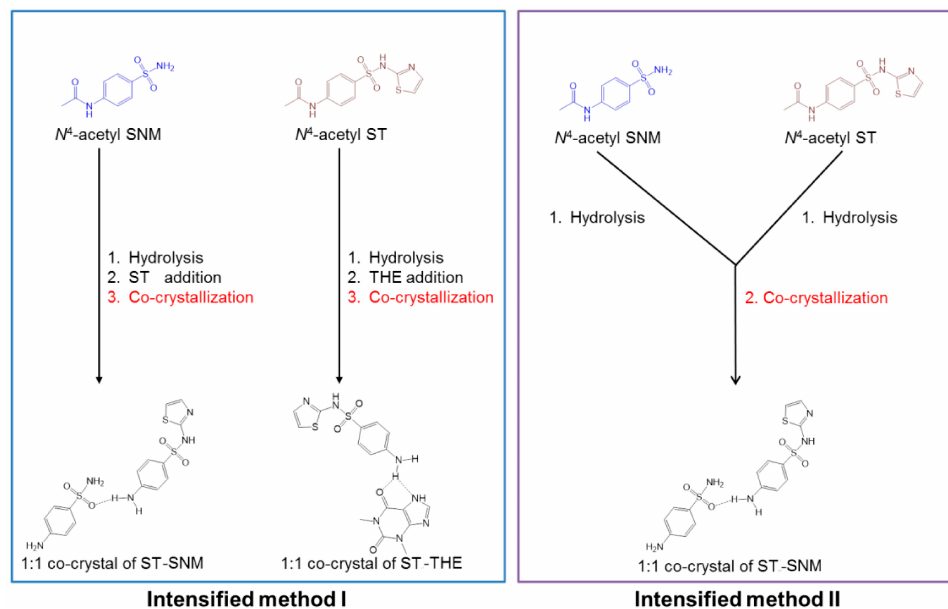
Figure 36. Intensified method for cocrystal preparation. Adapted with permission from Cryst. Growth Des., DOI: 10.1021/acs.cgd.7b01197 . Copyright 2018, American Chemical Society.